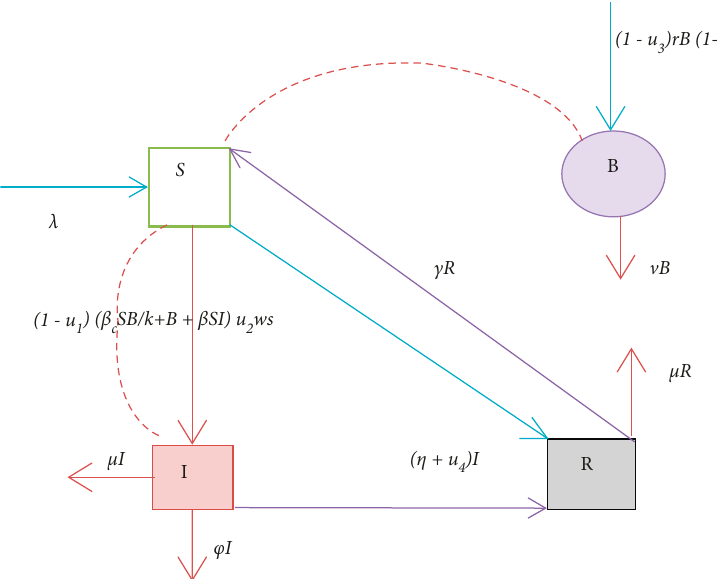
Figure 1: The flow diagram of SIR-B model of cholera transmission